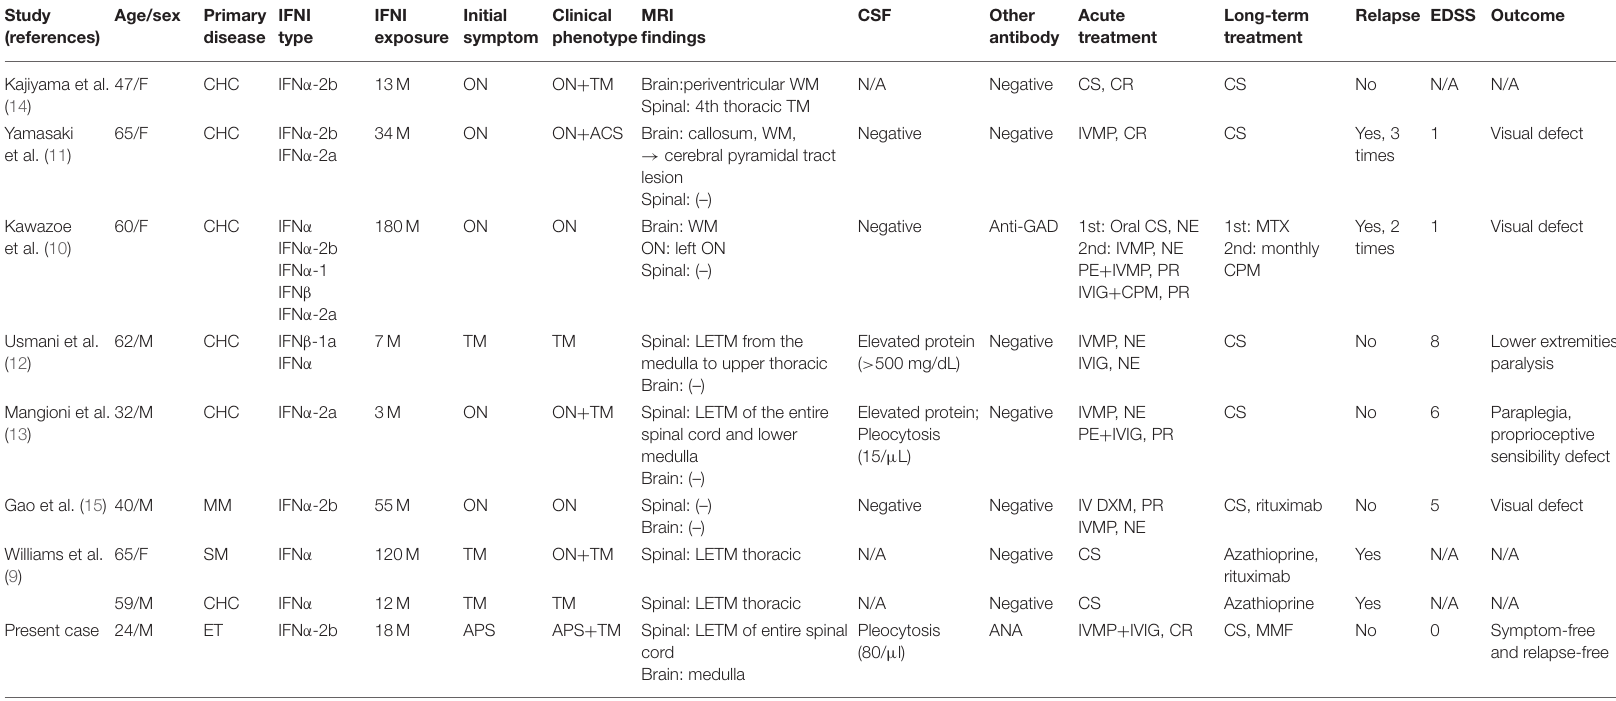
TABLE 1 | Characteristics of the patients with Interferon-alpha-induced neuromyelitis optica spectrum disorder